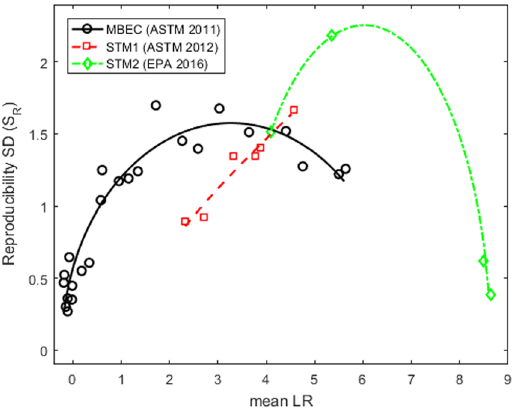
Figure 3. Reproducibility of methods that test antimicrobials against biofilms. Results are shown from multi- laboratory studies of 3 different methods that test agents against P. aeruginosa biofilms. The number of labs and products tested in each study are given in Table 1. The regression curves approximate the reproducibility SD (S R ) as a frown-shaped function of the mean LR for each method. Each point corresponds to S R and the mean LR attained by a single agent in a multi-laboratory